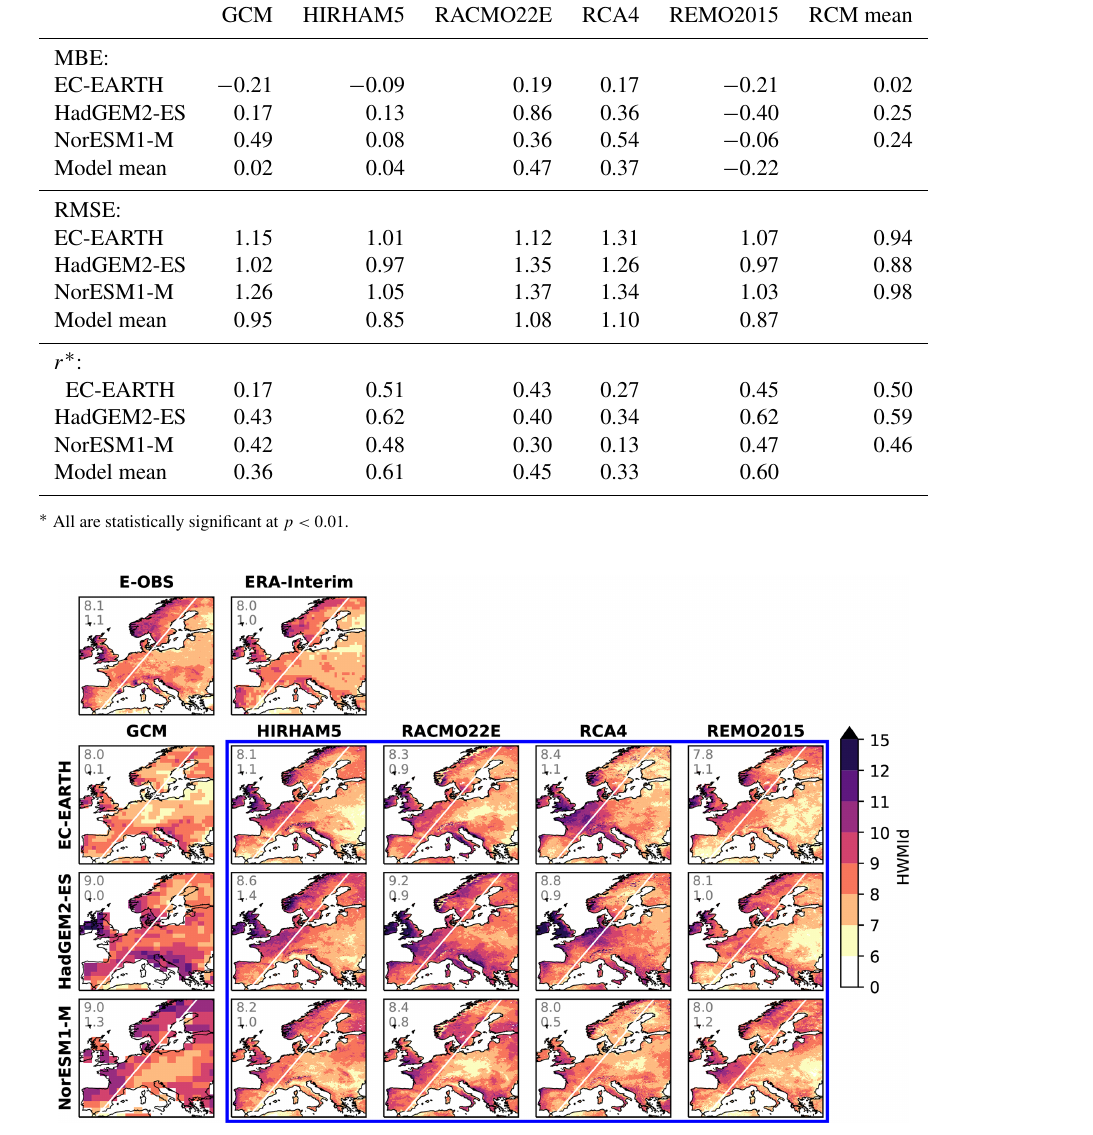
Figure 3. Climatological mean HWMId under the recent past climate (1981–2020) in the RCM simulation matrix (inside the blue rectangle; columns for RCMs and rows for their driving GCMs) as well as the driving GCM simulations. Data from E-OBS and ERA-Interim are also shown for comparison. The two numerals in each map show the area-weighted average over the entire domain and the difference between western and eastern parts divided by the white